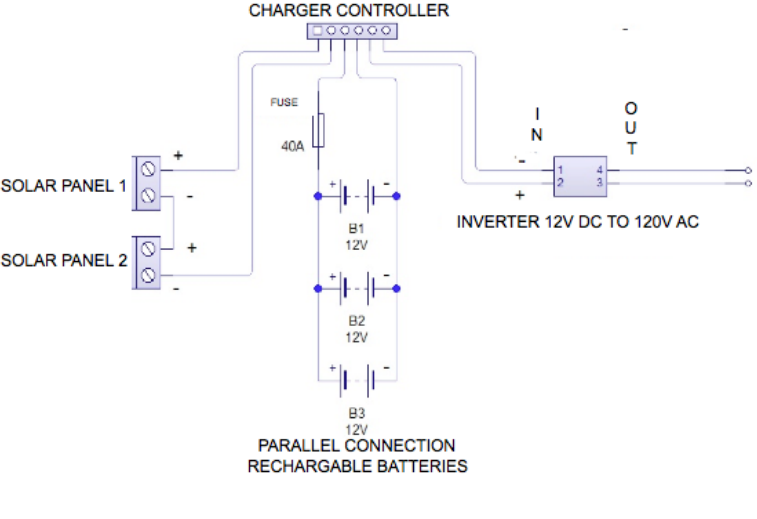
Figure 9. Connection diagram of the power source module for the base terminal